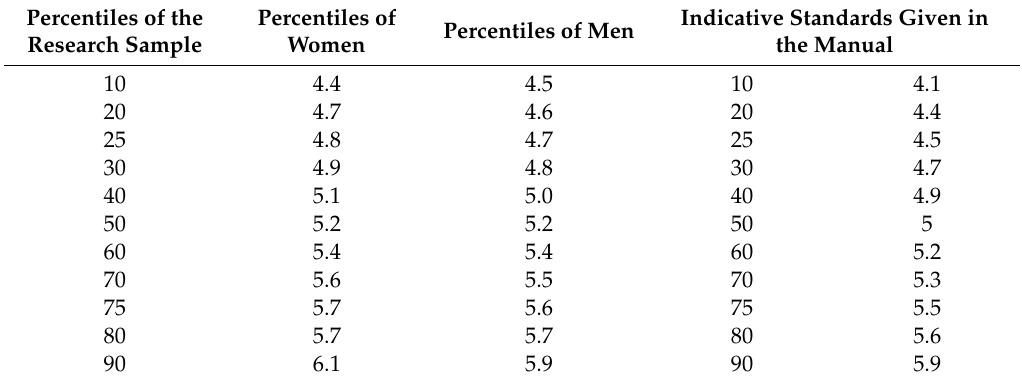
Table 4. Percentage standards for assessing the global level of emotional intelligence measured by the TEIQue SF